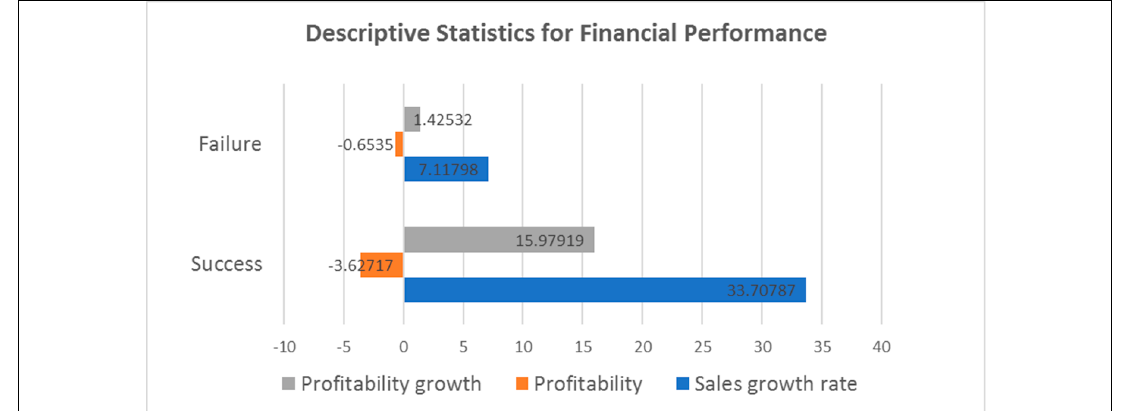
Figure 1. Bar chart of descriptive statistics for financial performance.